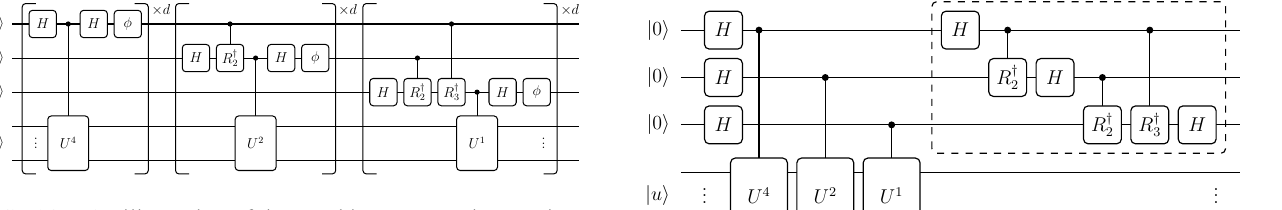
FIG. 14. An illustration of three-qubit quantum phase estima- tion using QSP.